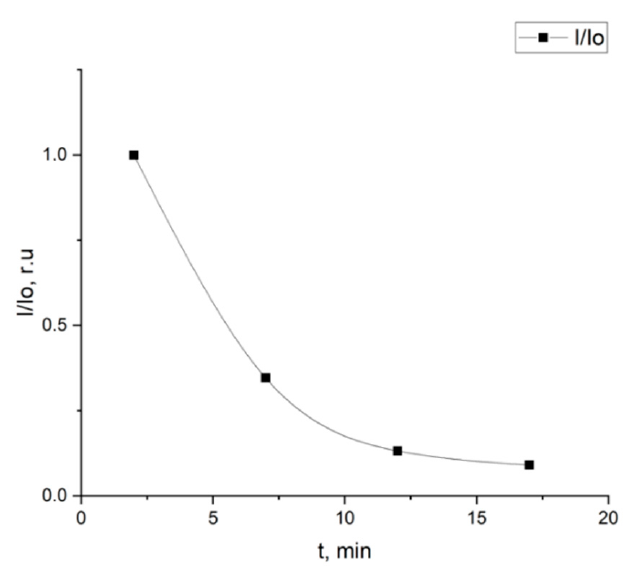
Figure 5. Ratio of intensity of the light transmitted by the dye blood plasma solution to the intensity of light transmitted by blood plasma solution from the time the plasma was taken from the patient.